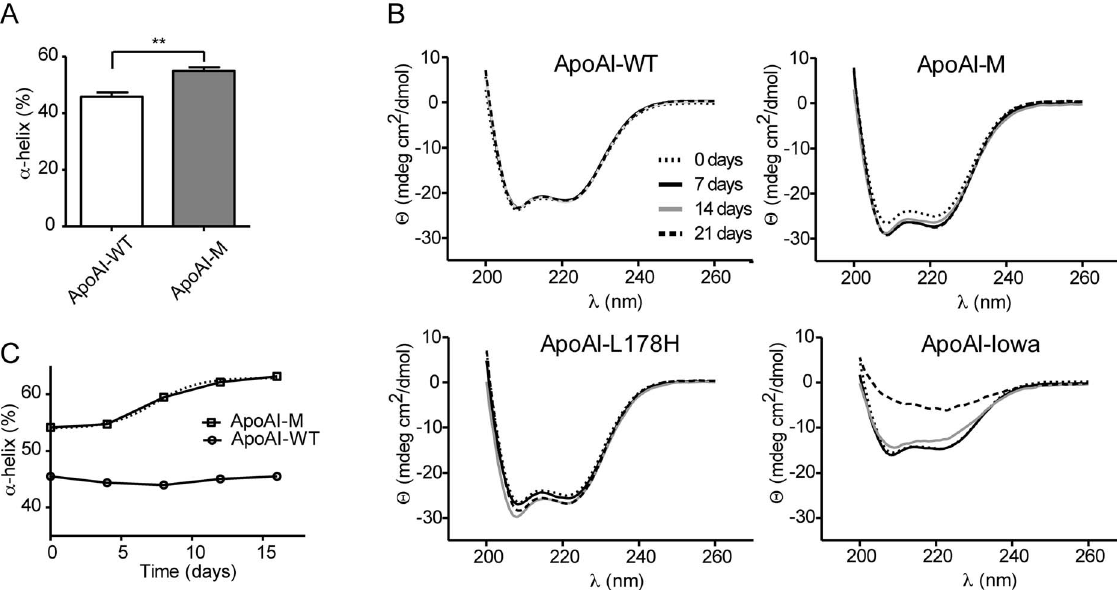
Figure 3. Structural transitions of apoA-I proteins assayed by CD spectroscopy. A , The alpha helical content was calculated from the value of molar ellipticity at the wavelength 222 nm at the time point 0 days for apoAI-WT and apoAI-M (25 u C). B , Circular dichroism spectroscopy was used to analyze secondary structure changes over time. Scans ranging from 200 nm to 260 nm of apoAI-Iowa (G26R), apoAI-Milano (R173C), apoAI-L178H and apoAI-WT proteins (at concentrations of 0.2 mg/ml) incubated at 37 u C for up to 21 days (0, 7, 14 and 21 days of incubation) are shown. While the secondary structure of apoAI-WT protein is unchanged during the time course, the spectral changes of the apoAI-Milano and the apoAI-L178H proteins indicate increased alpha-helical content (as indicated by an increase in molar ellipticity at 222 nm), whereas the amyloidogenic apoAI-Iowa displays a reduction in alpha helical secondary structure with time. C, The percentage of alpha helix was measured during 16 days of incubation at 37 u C at different time points (0, 4, 8, 12 and 16 days). Boltzmann function was used to determinate the transition time of the apoAI-Milano variant. ApoAI-WT did not exhibit any significant changes in the alpha helical content when incubated at identical conditions during same time period. **p , 0.01, n=3.